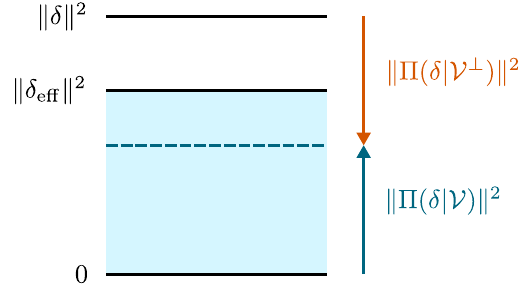
2 by either eff k